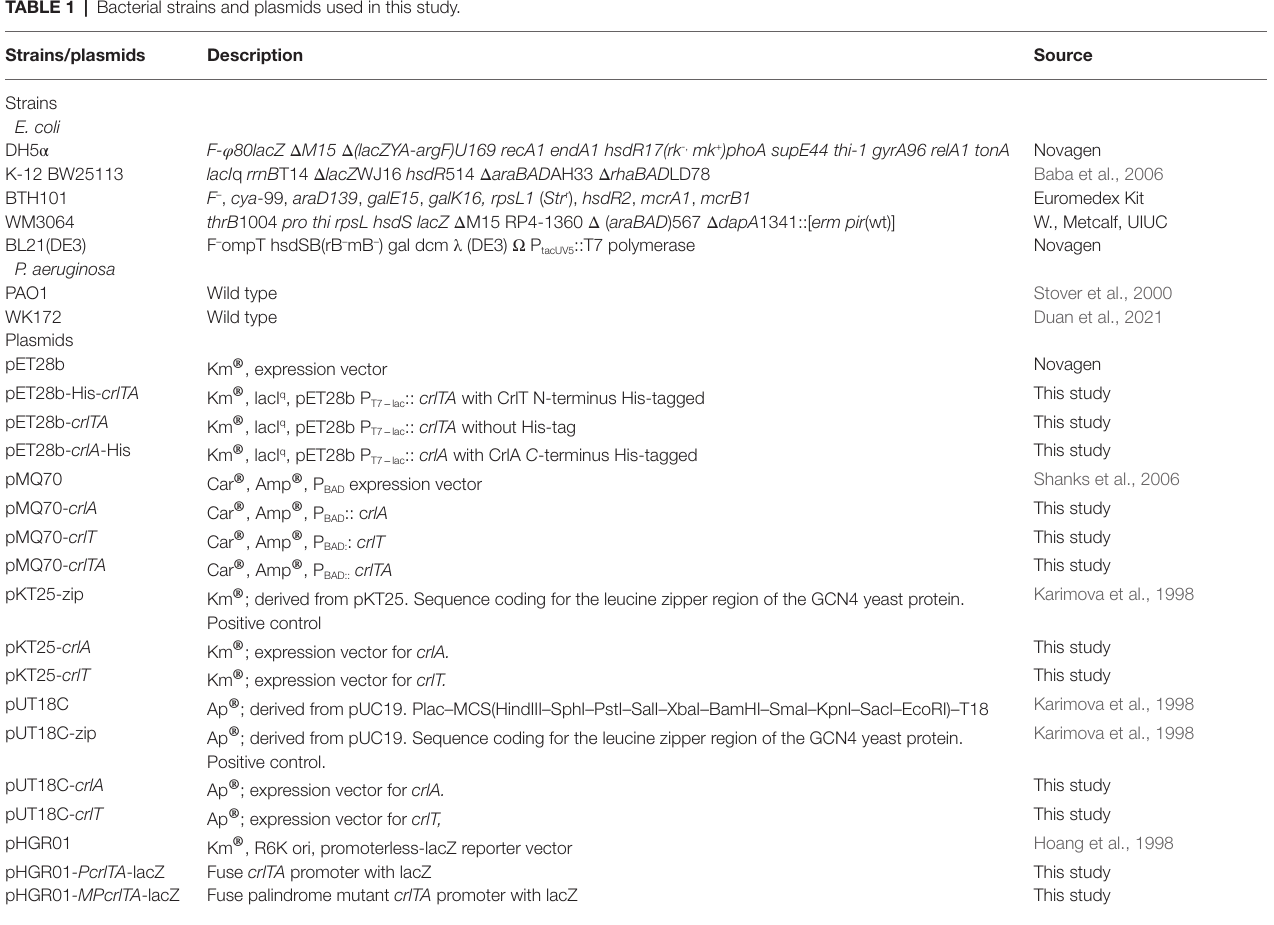
TABLE 1 | Bacterial strains and plasmids used in this